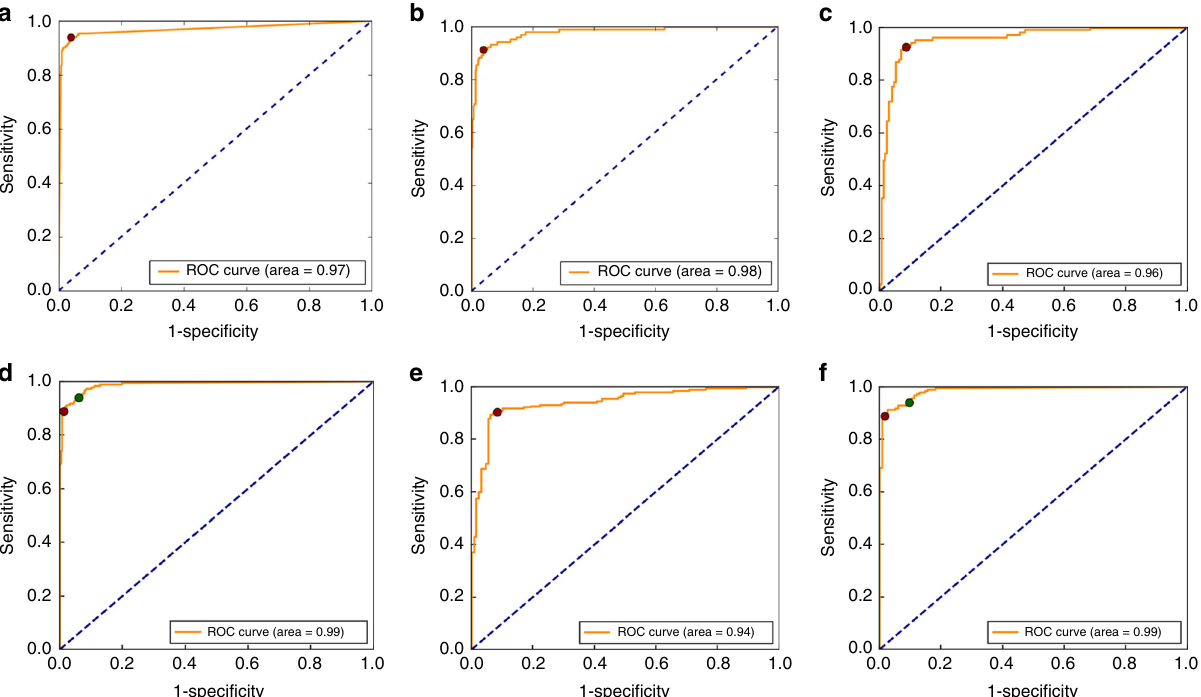
Fig. 4 Diagnostic receiver operating characteristics curves. Diagnostic receiver operating characteristics (ROC) curves, displaying the trade-offs between sensitivity and speci fi city for our narcolepsy biomarker for a training sample, b testing sample, c replication sample and e high pretest sample. d – f Adding HLA to model vastly increases speci fi city. Cut-off thresholds are presented for models with (red dot) and without HLA (green